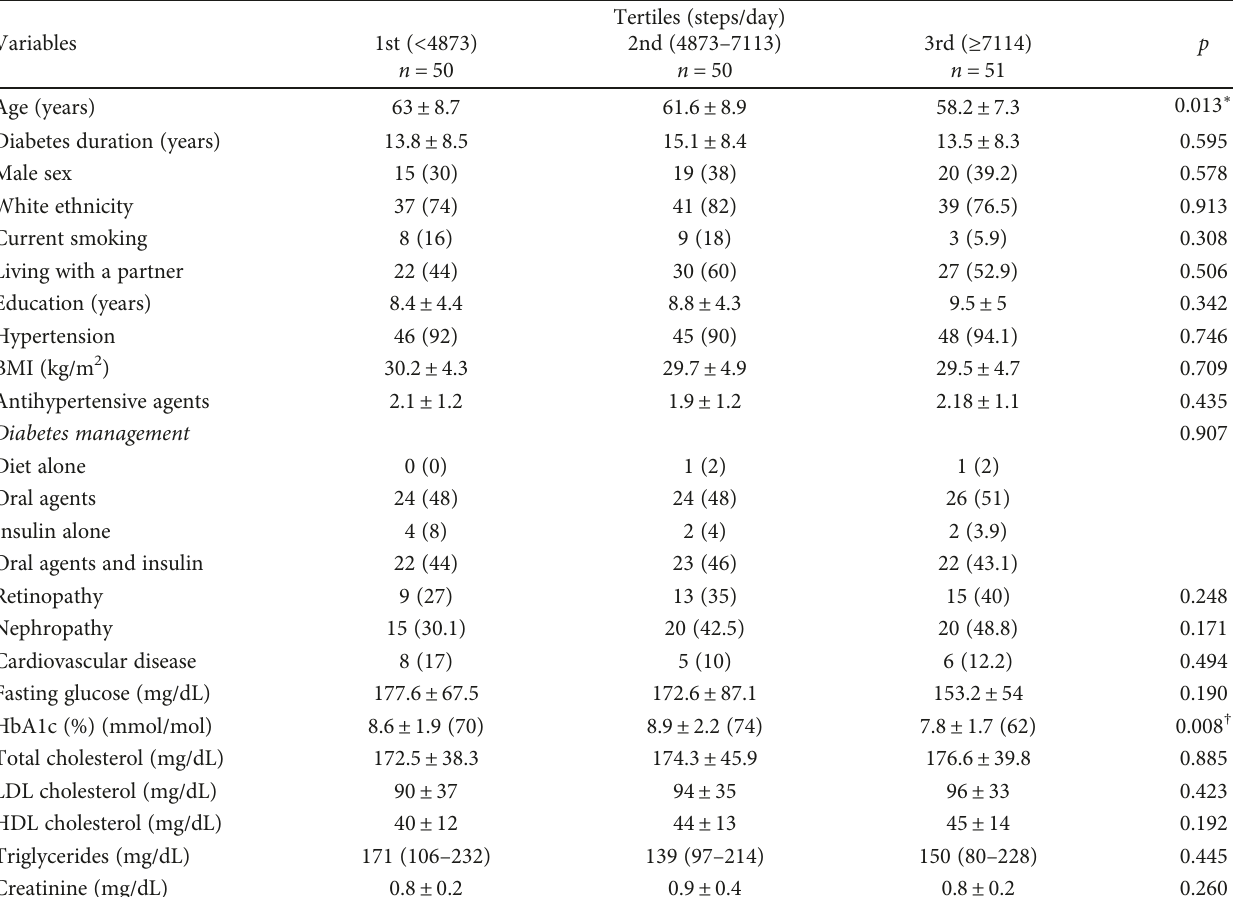
Table 1: Clinical pro fi le of the sample, strati fi ed by step count